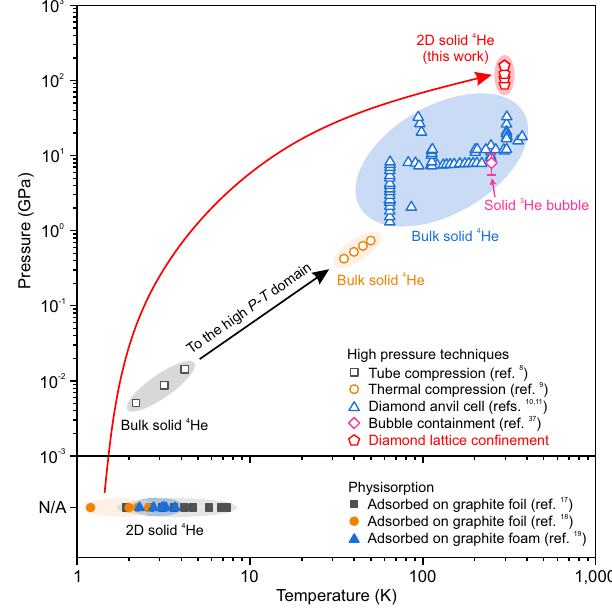
Fig. 4 | P - T domain ofthree-and two-dimensional solid helium. Helium was fi rst solidi fi ed by Keesom 8 in 1926. With the development of high-pressure techniques 9 – 11,37 , three-dimensional solid helium has been obtained at high P - T conditions. Nevertheless, two-dimensional solid helium has previously been achievedbyphysisorptiononthesurfaceofgraphiteatlowtemperatures 17 – 19 .Using diamond lattice con fi nement, we substantially extended the P - T domain of two- dimensional solid helium for potential practical applications. Source data are provided as a Source Data fi